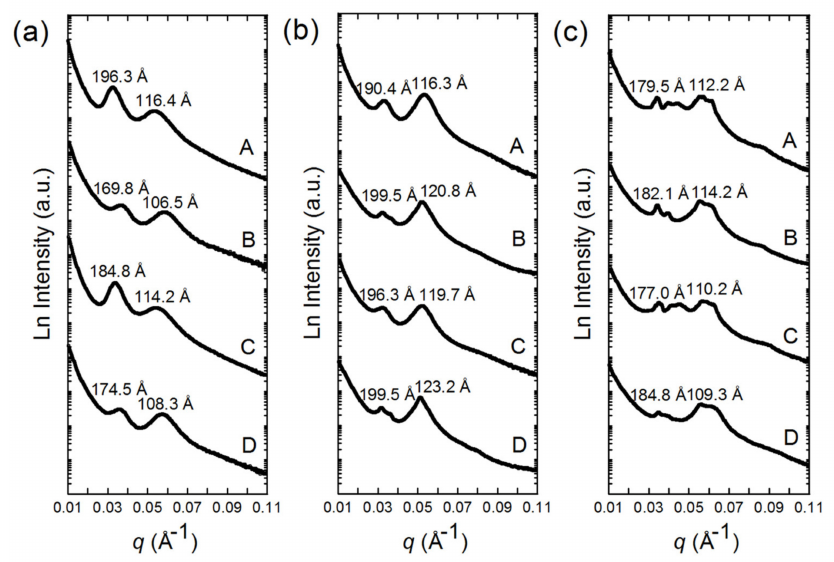
Figure 5. SAXS patterns of mesoporous organosilica samples: PMOF-1 ( a-A ), PMOF-2 ( a-B ), PMOF-3 ( a-C ), PMOF-4 ( a-D ), PMOA-1 ( b-A ), PMOA-2 ( b-B ), PMOA-3 ( b-C ), PMOA-4 ( b-D ), PMOB-1 ( c-A ), PMOB-2 ( c-B ), PMOB-3 ( c-C ), PMOB-4 ( c-D